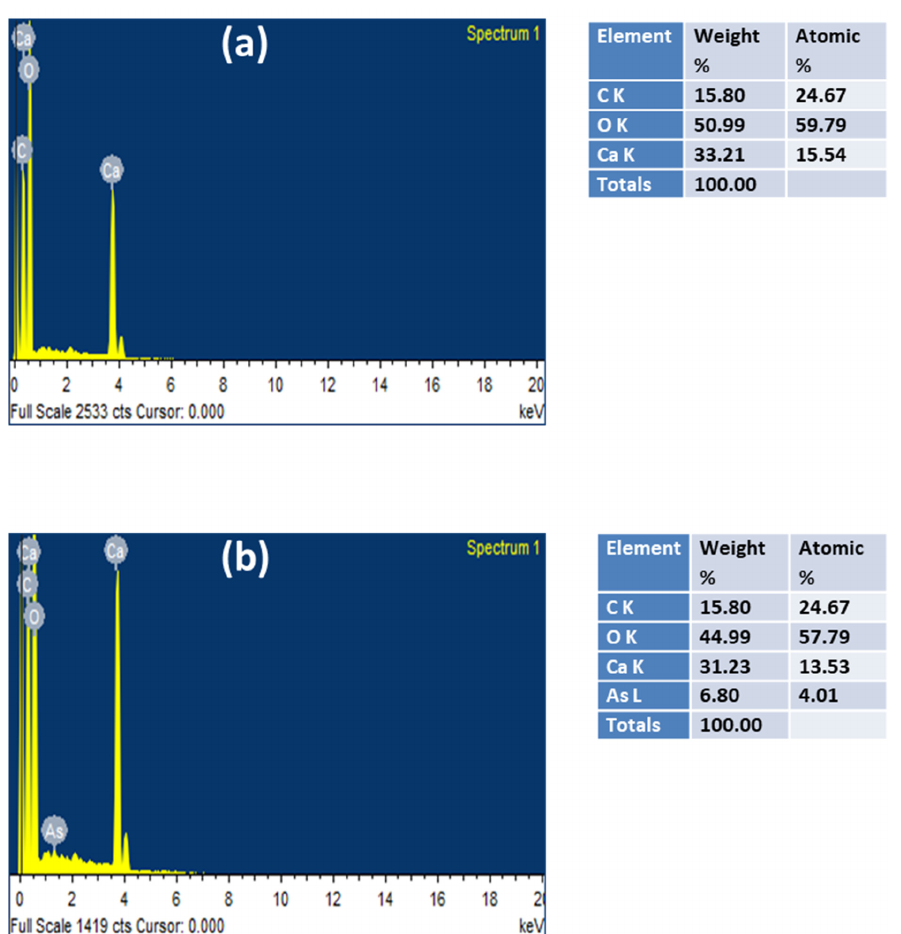
Figure 6. EDS data of As(V) sorption on egg shell biochar: ( a ) raw biochar; ( b ) As(V)-loaded biochar.